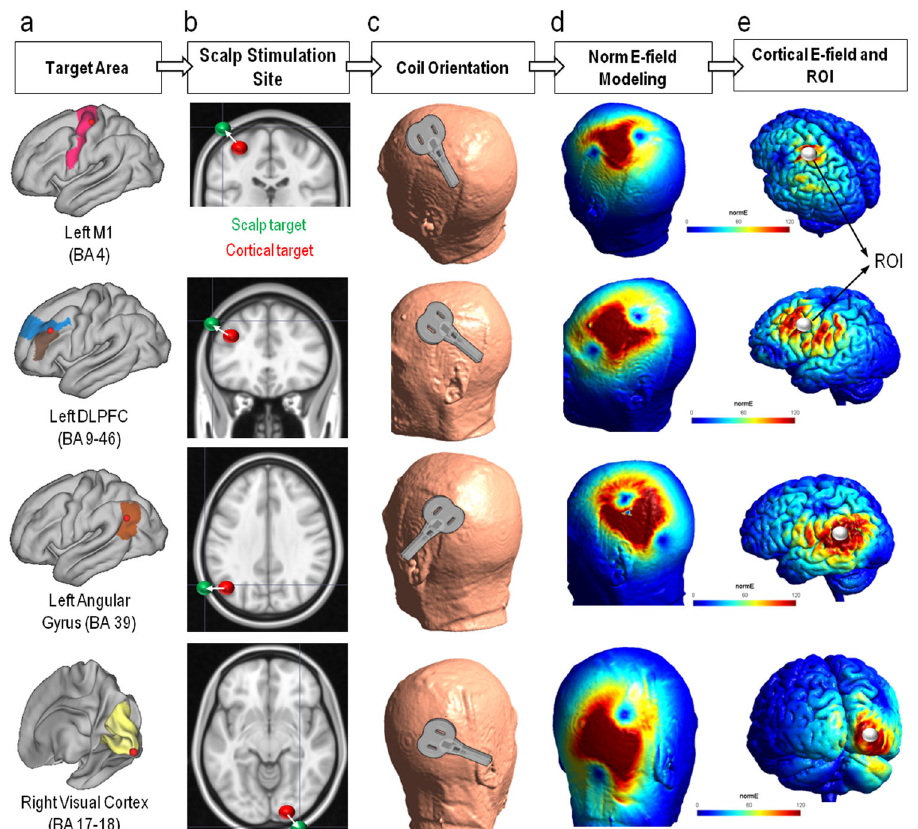
Fig. 4 Process for TMS simulations and NormE value extraction. The fi gure shows the process used to identify the stimulation sites, TMS coil placement and orientation, and extraction of the resulting NormE. a We focused on four regions as potential stimulation targets for their relevance for neuromodulation protocols in space travelers: left primary motor cortex (M1), left dorsolateral prefrontal cortex (DLPFC), left angular gyrus, and right visual cortex. The set of coordinates for each cortical target was chosen from up-to-date literature (see main text for details). The panel shows the targets (red spheres) and the corresponding Brodmann Area (BA). b We created a set of spherical region-of- interest (ROI) centered in the coordinates (red spheres enlarged in the fi gure to allow visualization). The ROIs were overlapped on the MRI T1- w in an MNI standard brain and moved 90 degrees oblique toward the outside until reaching the scalp. We saved the position on the skin as scalp targets (green spheres). c We centered the coil in this new set of coordinates for stimulation sites on the scalp. The coil handle was then manually rotated to recreate the orientation normally employed in an experimental setting. In the main text, we also report the set of MNI coordinates for the corresponding orientation of the coil handle, in order to ensure the same precise orientation for each participant. All MNI coordinates were converted to subject space thanks to SimNIBS. d We then ran the simulation of TMS pulse computing the resulting NormE distribution for each participant, at each time-point (baseline, post- fl ight, follow-up) on the four stimulation sites. The resulting output from one of the cosmonauts enrolled in the study is shown in the panel. e To compute the current strength reached by the cortical areas we were interested in, the NormE was extracted in the gray matter of the area stimulated for each individual at each time-point. The ROI spheres previously created with coordinates in cortical targets are here presented in white and enlarged to allow visualization. We intersected them with the layer of gray matter within the TMS-generated electric fi eld. The weighted average NormE in every tetrahedron of the mesh